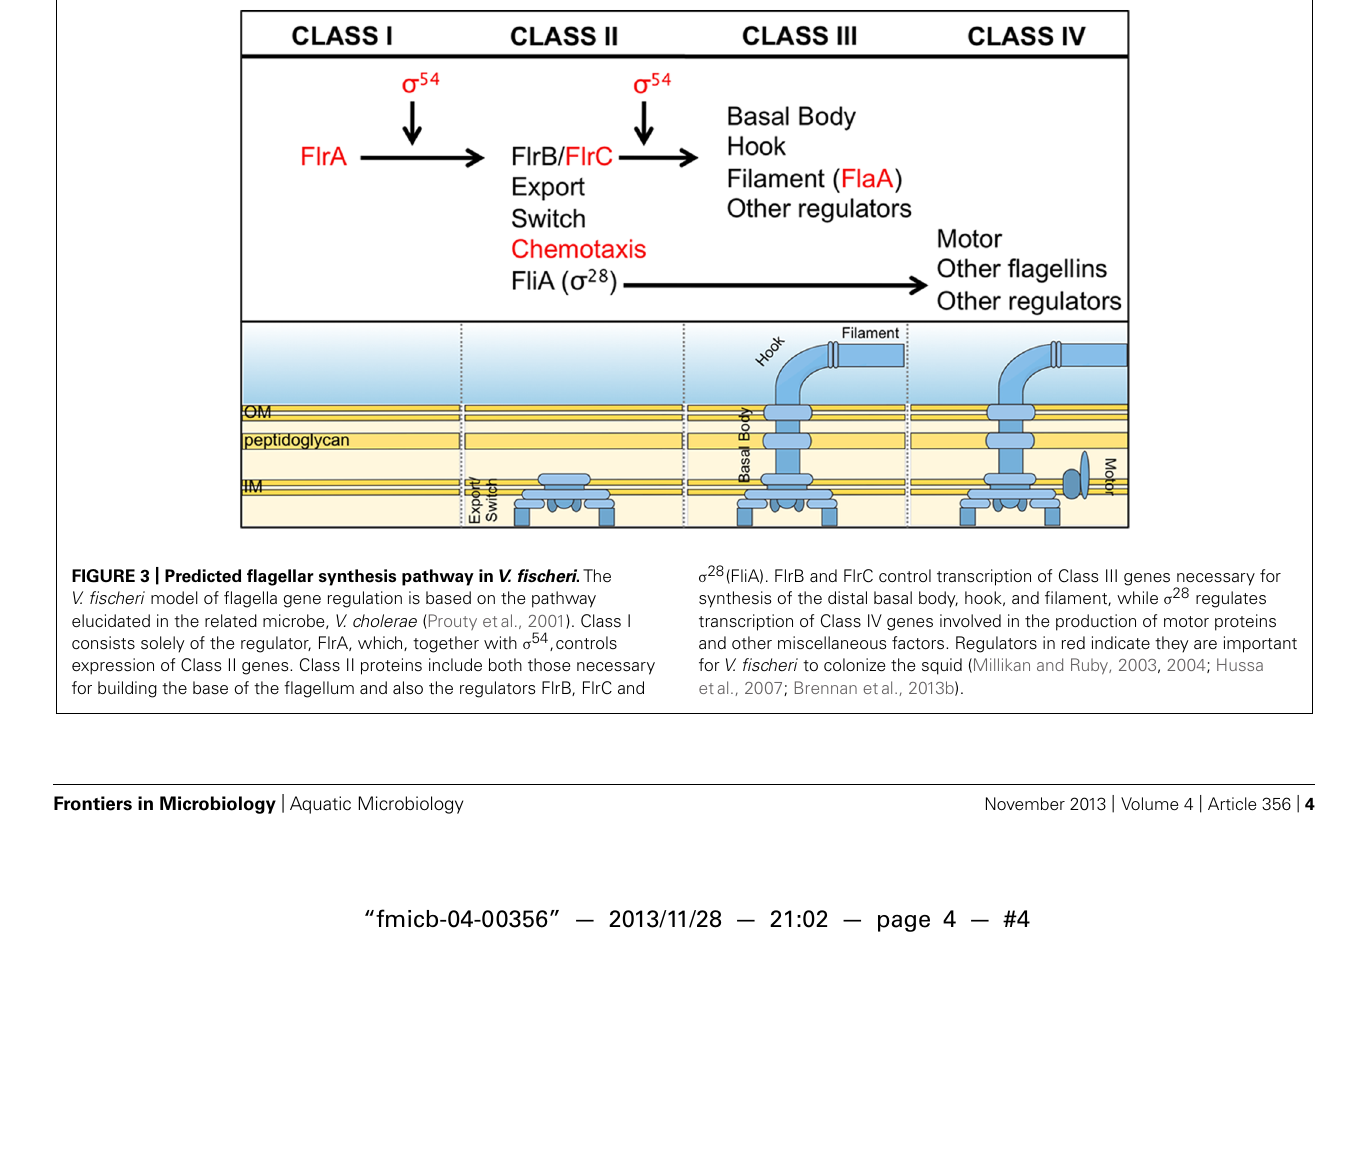
FIGURE 3 | Predicted flagellar synthesis pathway in V. fischeri . The V. fischeri model of flagella gene regulation is based on the pathway elucidated in the related microbe, V. cholerae (Prouty etal., 2001). Class I consists solely of the regulator, FlrA, which, together with σ 54 ,controls expression of Class II genes. Class II proteins include both those necessary for building the base of the flagellum and also the regulators FlrB, FlrC and